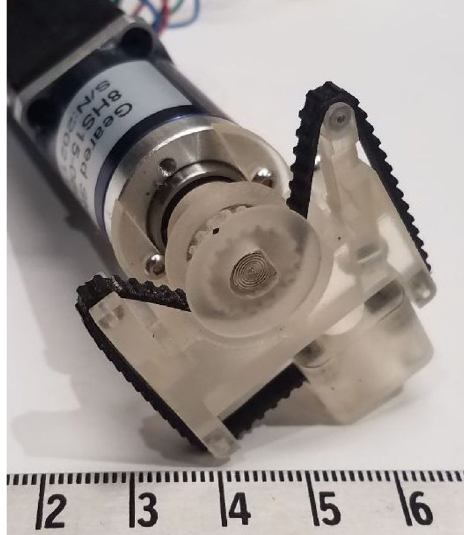
FIG. 5. Photograph of an assembled, belt-actuated drivetrain module, shown with a ruler with 1 cm